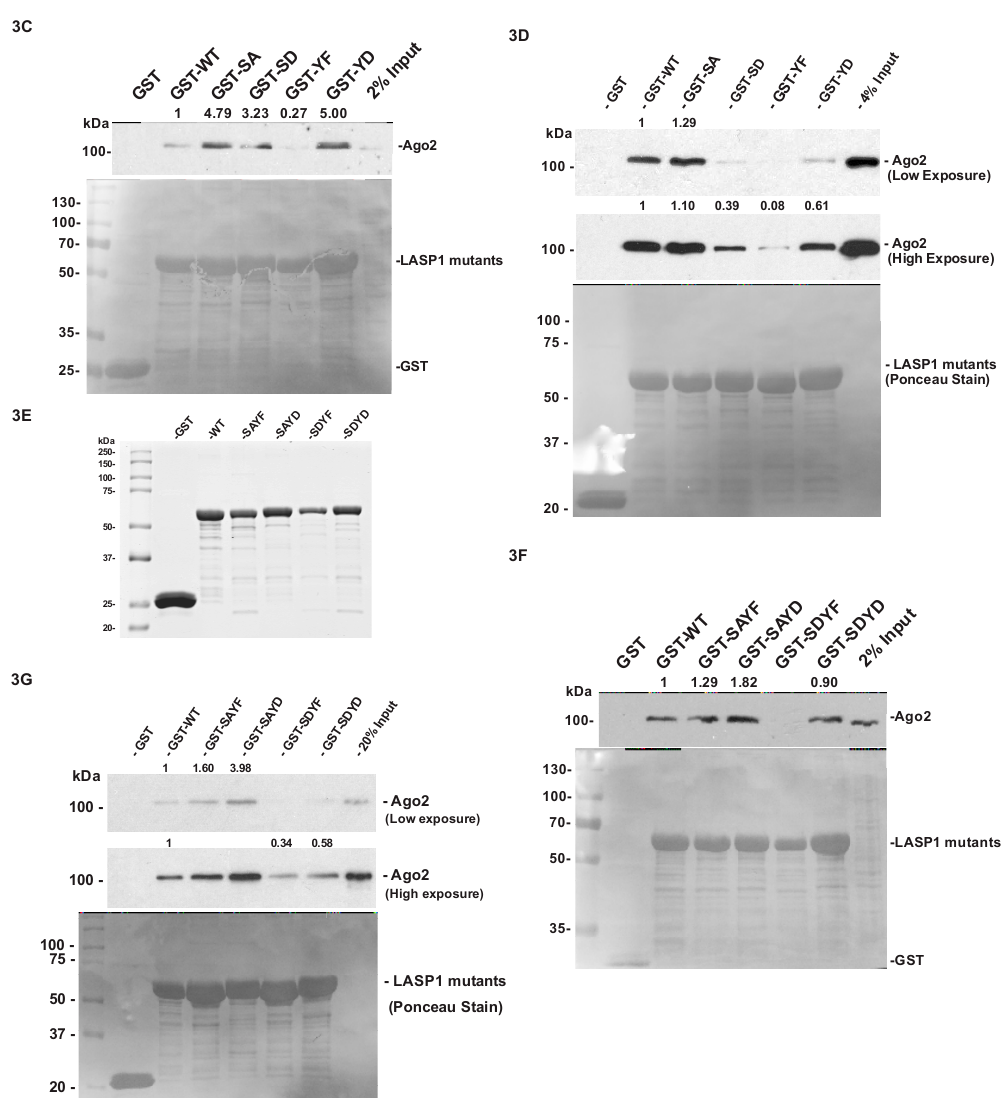
Figure 3. Phospho-Mutants of LASP1 Differentially Interact with Ago2. ( A ) Schematic diagram of designed LASP1 phosphorylation mutants. ( B ) Representative profile of purified GST-LASP1 single phospho-mutants: 1.5 nmol of each purified mutant was resolved by 10% SDS-PAGE and visualized by staining with Imperial Blue stain. ( C ) LASP1 single-mutant pulldown for Ago2: 1 mg of Bone-Un LASP1 KO total lysate was incubated with 1.5 nmol of each LASP1 single-mutant protein. Associated Ago2 was detected by immunoblot analysis and loading of GST-fusion proteins was visualized by Ponceau S staining. ( D ) Direct binding of LASP1 single-mutants to recombinant Ago2: 100 ng of purified recombinant Ago2 was incubated with 1.5 nmol of each purified single-mutant protein. Directly bound Ago2 was detected by immunoblot analysis and loading of GST-fusion proteins was visualized by Ponceau S staining. ( E ) Representative profile of purified GST-LASP1 double phospho-mutants: 1.5 nmol of each of the purified proteins were resolved by 10% SDS-PAGE and proteins were visualized by staining with Imperial Blue stain. ( F ) LASP1 double-mutant pulldown for Ago2: 1 mg of Bone-Un LASP1-KO total lysate was incubated with 1.5 nmol of each of the double-mutants. Associated Ago2 was detected by immunoblot analysis and loading of GST-fusion proteins was visualized by Ponceau S staining. ( G ) Direct binding of LASP1 double-mutants to recombinant Ago2: 100 ng of purified recombinant Ago2 was incubated with 1.5 nmol of purified LASP1 double mutants. Directly bound Ago2 was detected by immunoblot analysis and loading of GST-fusion proteins was visualized by Ponceau S staining. Uncropped version of the Western Blots is available in Figure